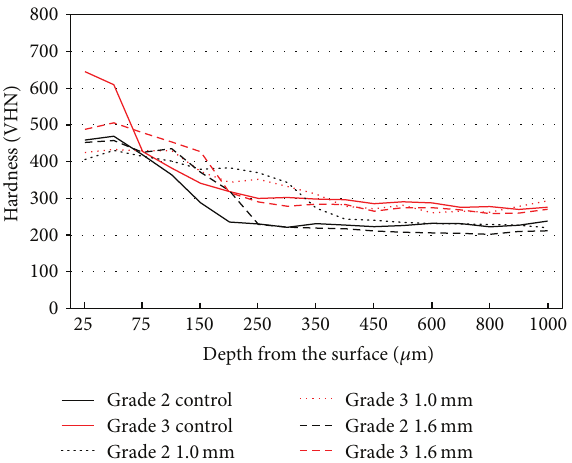
Figure 10: Hardness depth profiles from cast surface for control specimens (grade 2: black solid line, grade 3: red solid line) and specimens laser-treated with two different pulse durations (10ms and 1ms) at a constant emission current (220A) and a spot diameter